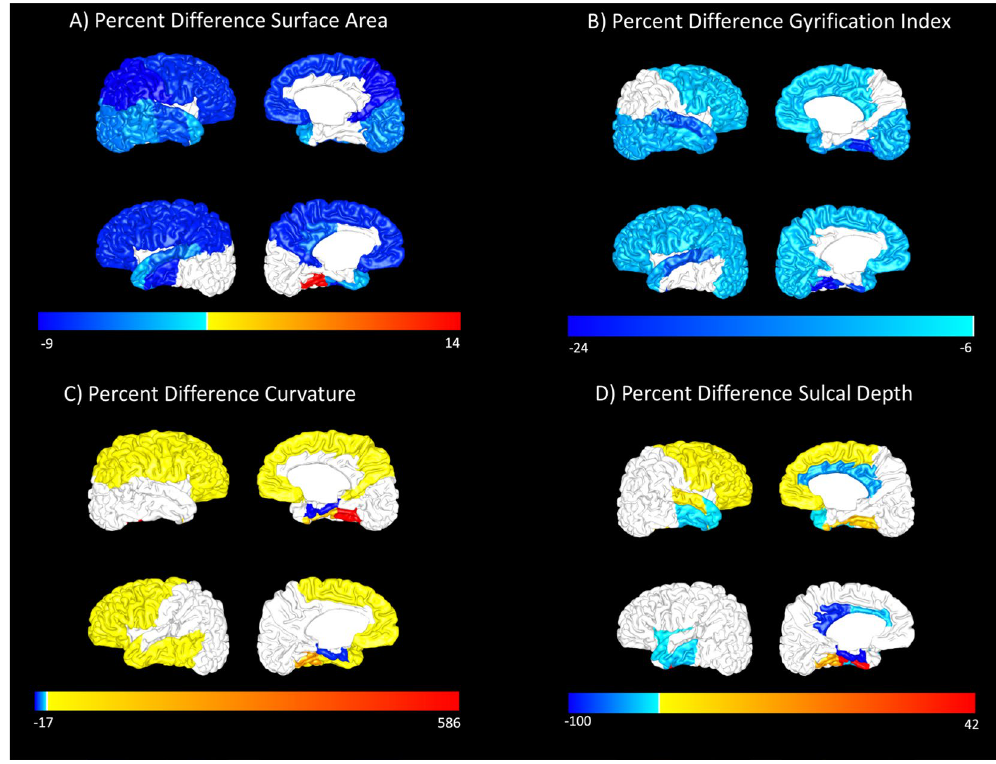
Figure 1. An example T2-weighted MRI scan from one VPT subject is shown in sagittal, coronal, and horizontal views (top row). A segmentation from the Developing Human Connectome Pipeline (dHCP) is overlaid on the original image (bottom row). The dHCP performs cortical and sub-cortical volume segmentation, cortical surface extraction, and cortical surface inflation and was specifically designed for neonatal T2-weighted MRI brain scans.